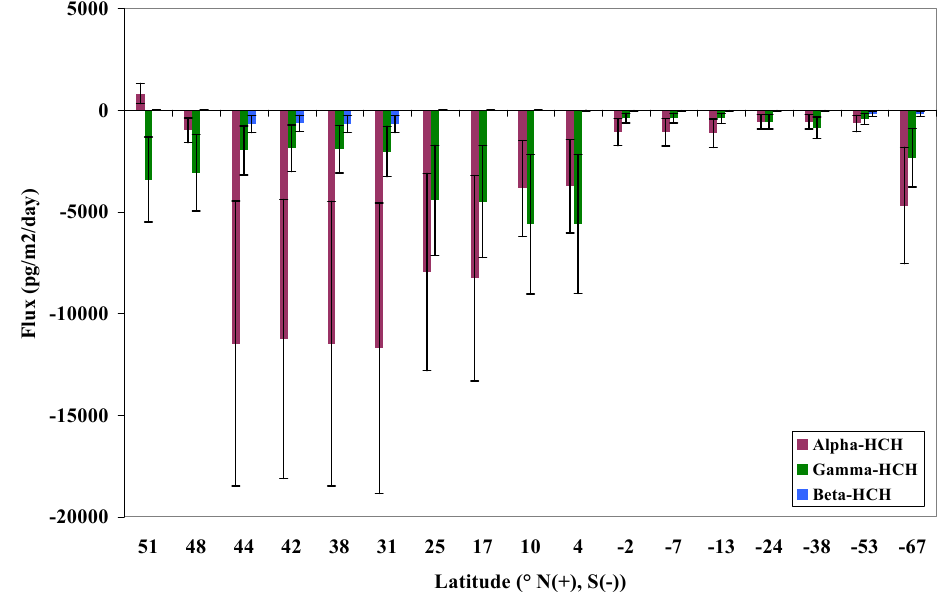
Fig. 6. Air-water gas exchange fluxes (pgm − 2 day − 1 ) for α -, γ - and β -HCH in the Atlantic and Southern Ocean, negative value means net deposition, and positive value means